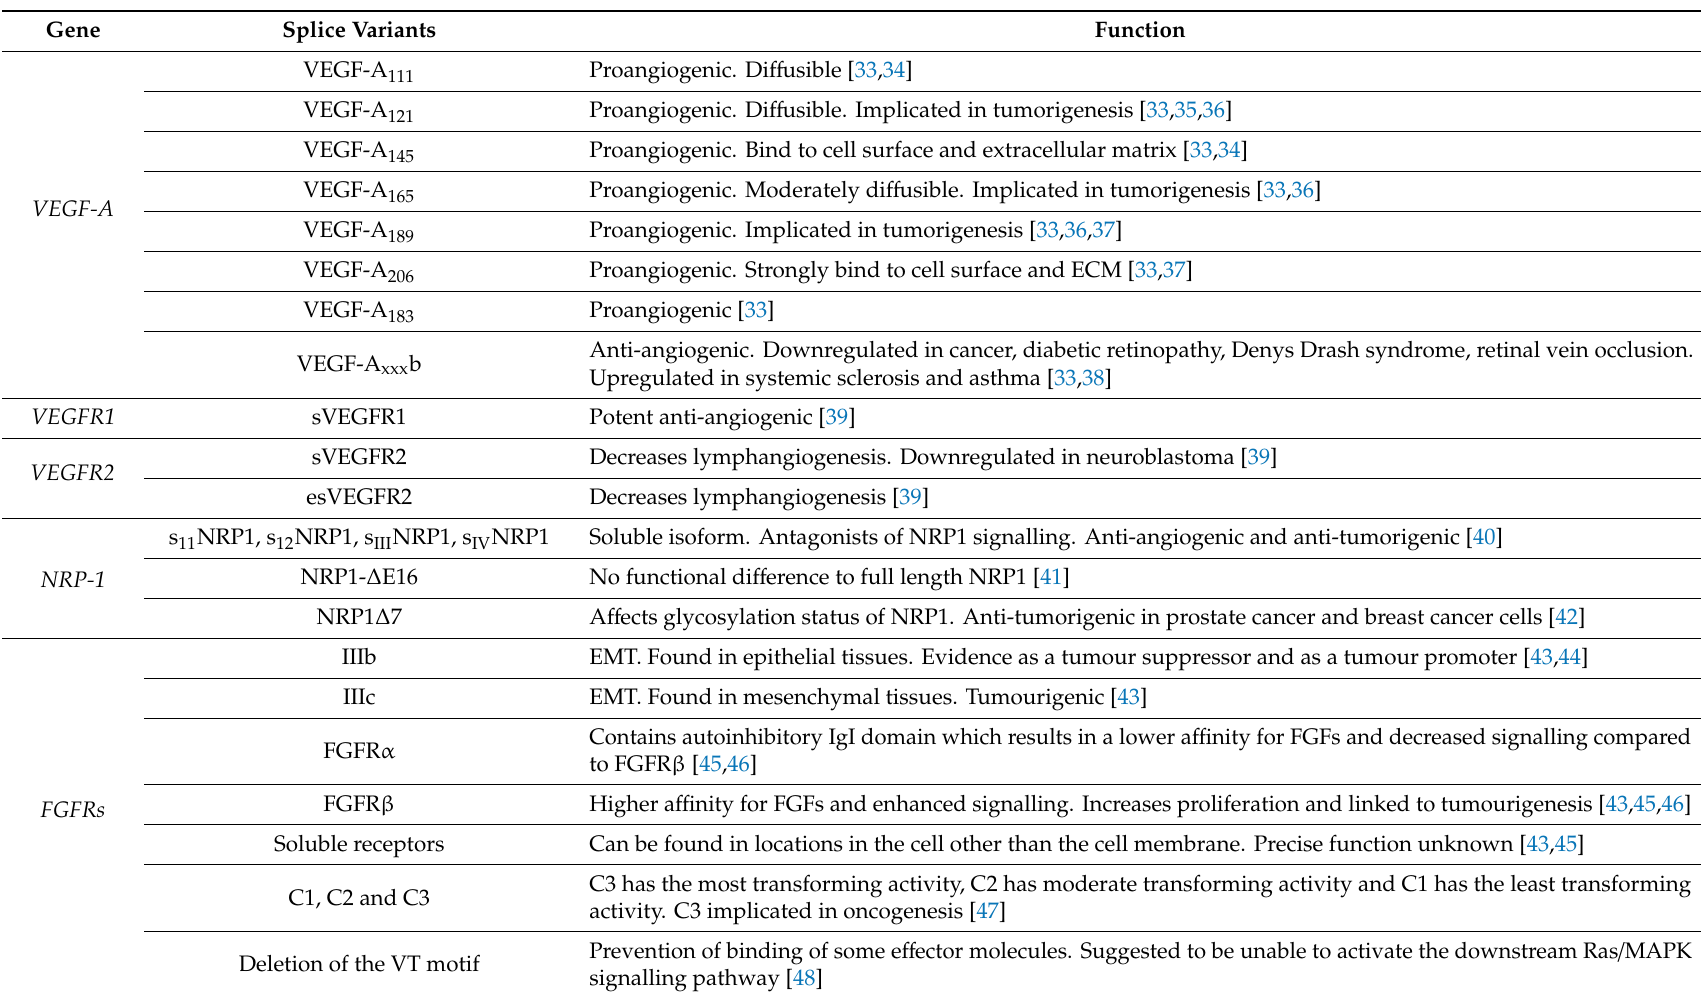
Table 1. Splice isoforms of key angiogenic genes and their known